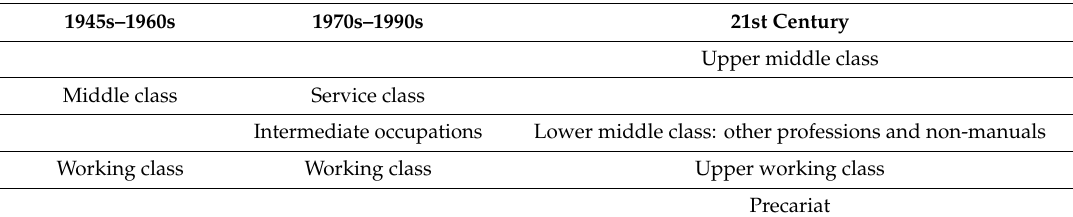
Table 2. Changes in the class